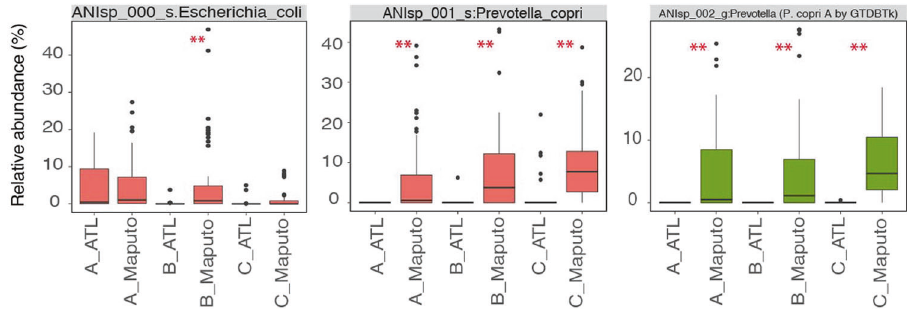
Fig. 2 The relative abundance of Escherichia coli and two Prevotella species in Atlanta vs Maputo gut microbiomes. Labels on x -axis of each boxplot denote the age and region of the samples (sample names are as in Fig. 1). (Signi fi cantly different at ** P adj < 0.01, * P adj < 0.05, Dunn ’ s post-hoc test). Results for all 52 genomospecies are available in Fig. S6 and Table